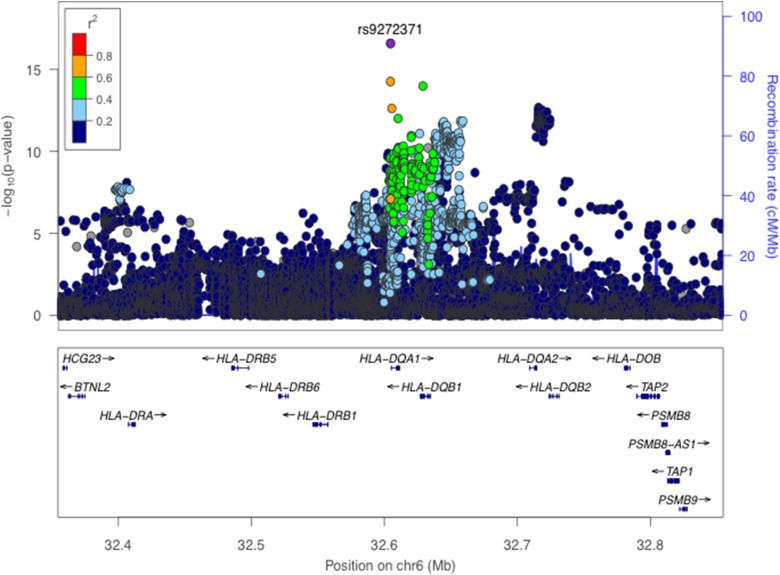
Regional association plot for anti-EBNA-1 IgG response levels in 1473 individuals. (Genome-Wide significance threshold = p < 5 × 10−9). The lead SNP rs9272371 (p = 2.6 × 10−17) located in an intron in HLA-DRB1 on chromosome 6 is labelled and coloured in purple. LD (r2) was calculated based on the Ugandan SNP genotypes used in this study.